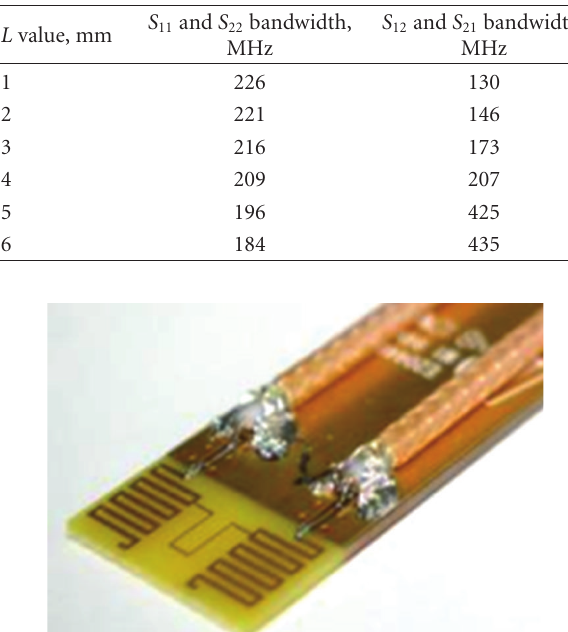
Table 1: S 11 and S 21 bandwidths for di ff erent L .